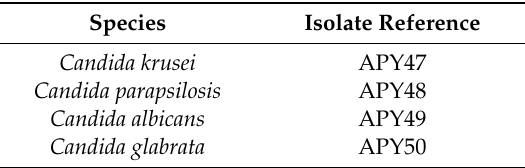
Table 3. Strain names for Candida spp.